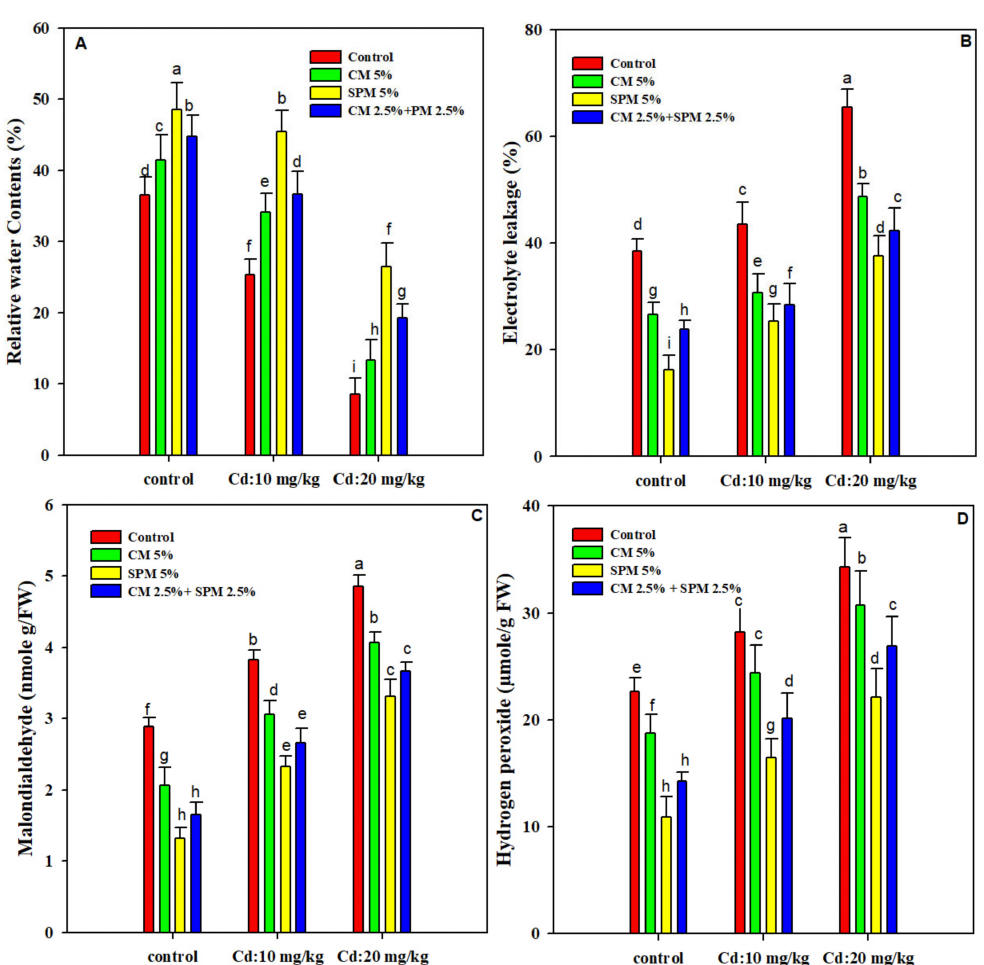
Figure 3. Effect of organic amendments on RWC ( A ), electrolyte leakage ( B ), MDA ( C ) and H 2 O 2 ( D ) contents of mash bean plants subjected to different levels of Cd stress (0, 10 and 20 mg/kg). The vertical bars in each figure are the mean of three replications with ± S.E. and different letters on bars indicating the significant difference at p <